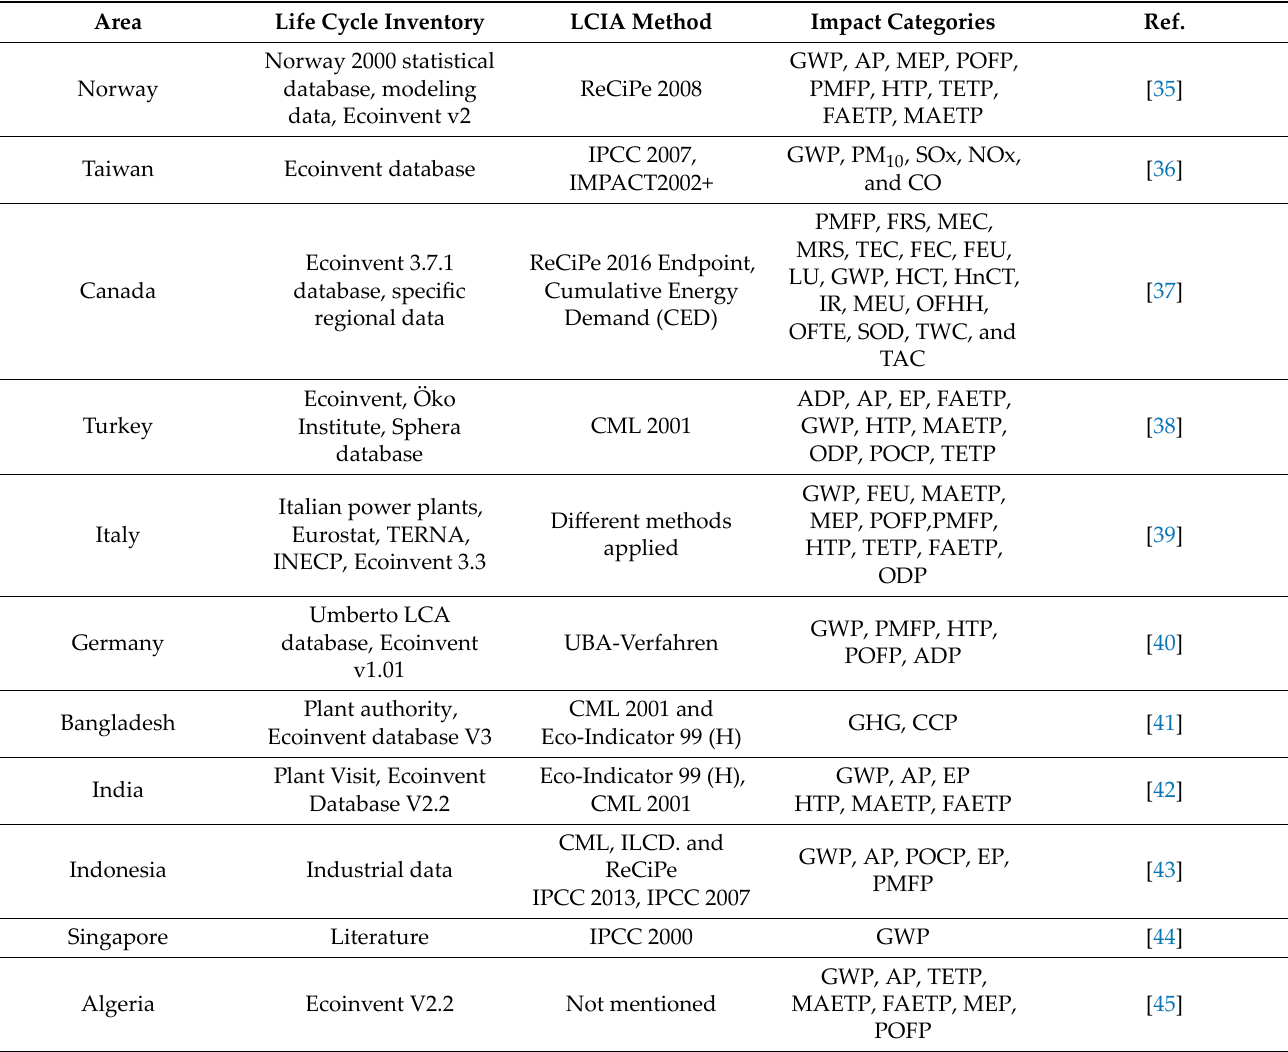
Table 1. Previous LCA studies and methods used for LCIA on CCS in NGCC power